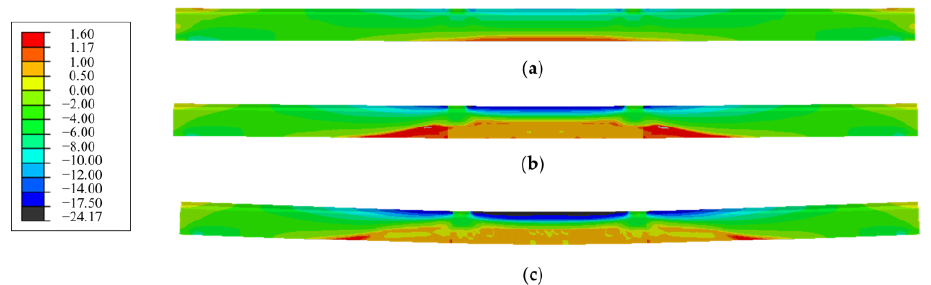
Figure 14. Nephogram of concrete stress along span of the strengthened beam under: ( a ) cracking load (0.73 P 0 ); ( b ) service load P 0 ; ( c ) ultimate load.